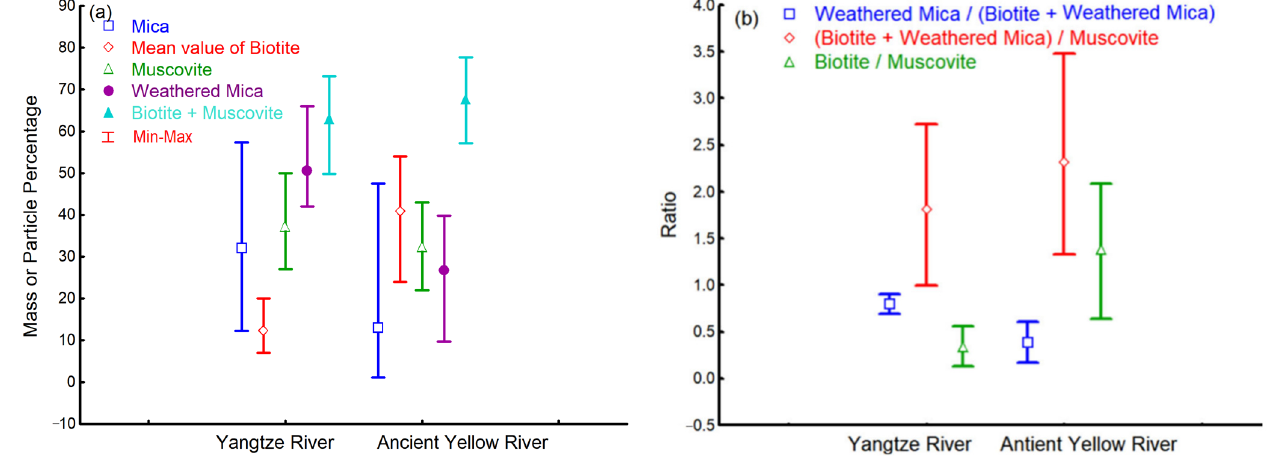
Figure 6. Comparison of the detrital mica contents ( a ) and ratios ( b ) in the very fine sand fraction of the sediments between the Yangtze River Estuary and ancient Yellow River Estuary. ( a ) shows the differences of mass percentage of mica (in bule) and particle percentages of biotite (in red), muscovite (in green), weathered mica (in purple) and sum of biotite and muscovite (in cyan). ( b ) shows the differences of particle percentage ratio of weathered mica to the sum of biotite and weathered mica (in blue), particle percentage ratio of the sum of biotite and weathered mica (in red), and particle percentage ratio of biotite to muscovite (in green).